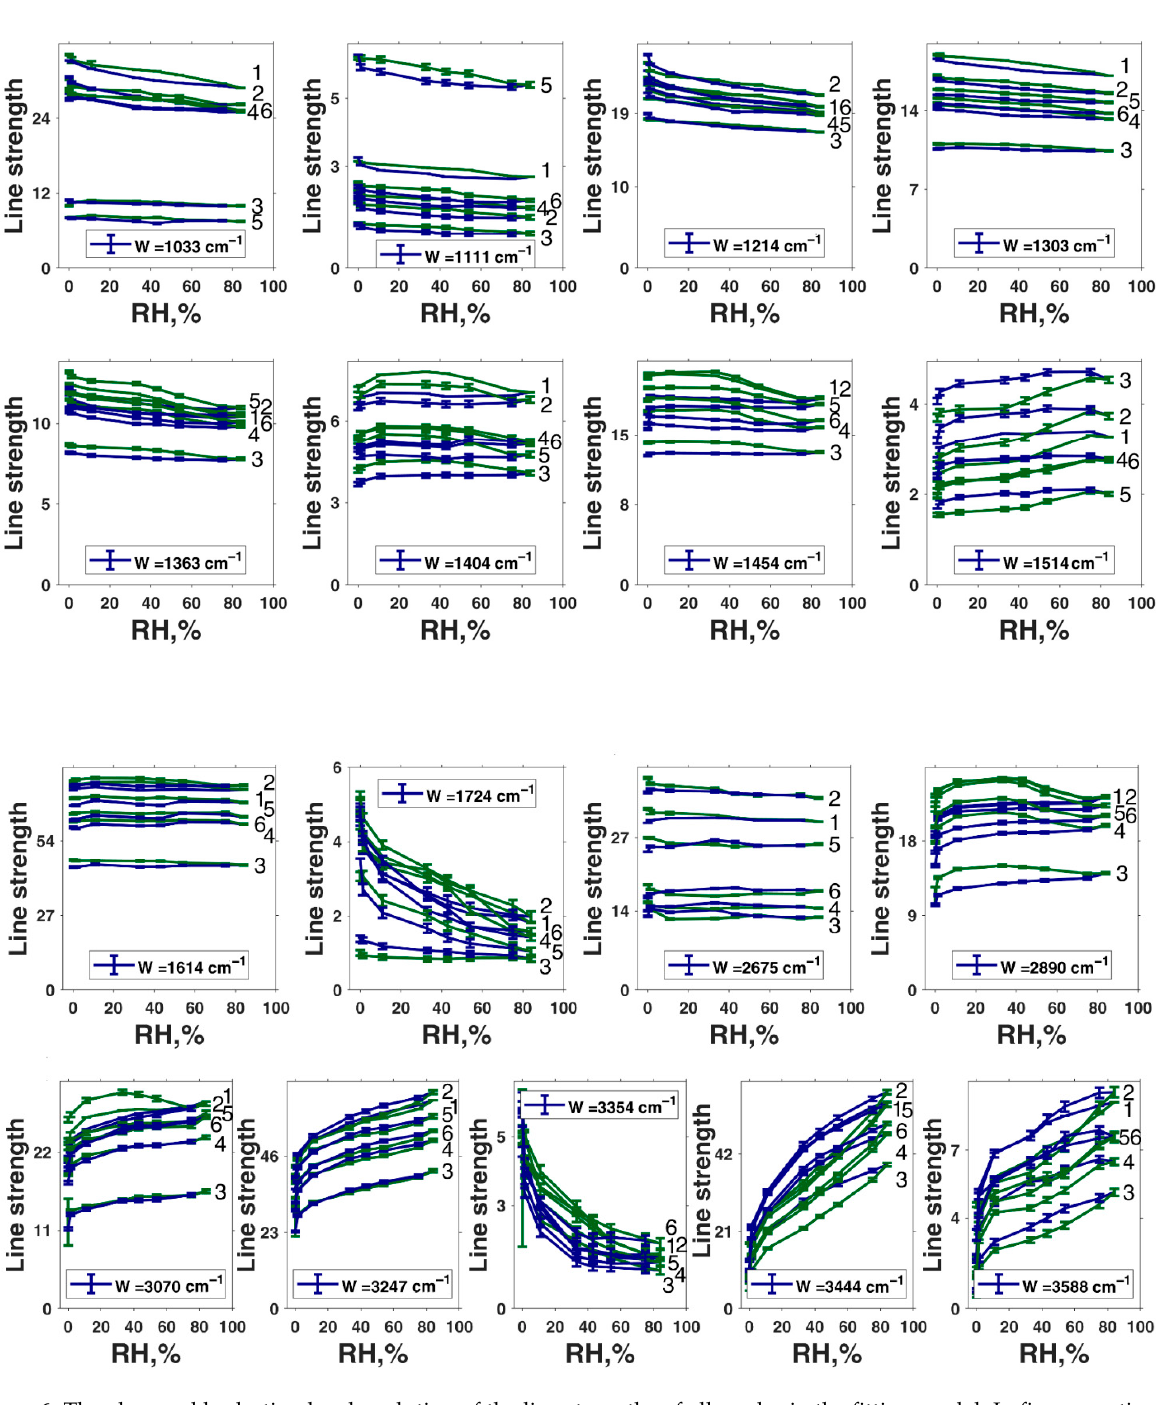
Figure 6. The observed hydration level evolution of the line strengths of all modes in the fitting model. In figure captions, W refers to the central wavenumber of the mode in cm − 1 . The error bars were estimated from the L-M LSDM algorithm. The six lines on each inset numbered on the right refer to the six measured positions on the film. Each line consists of the green and blue parts: the green part corresponds to the RH change from 0% to 84%; the blue part corresponds to the RH change from 84% to